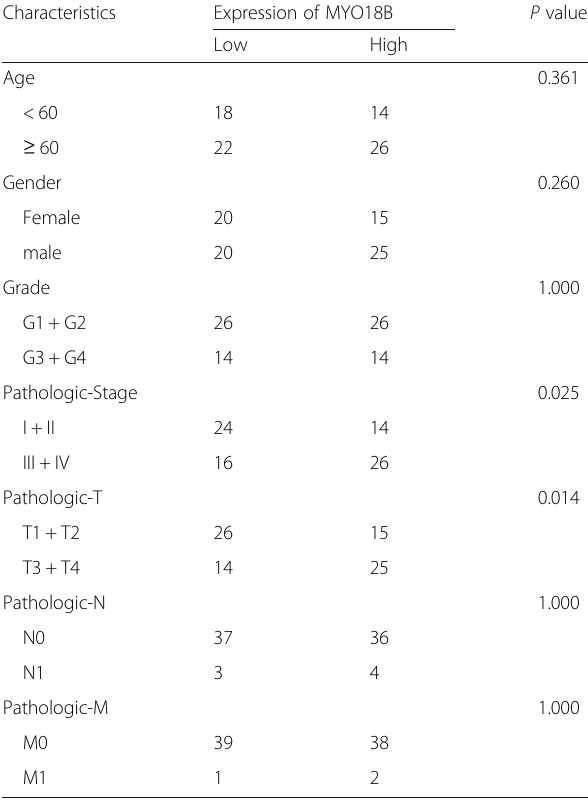
Table 1 Correlation between MYO18B expression and clinical characteristics in patients with hepatocellular carcinoma